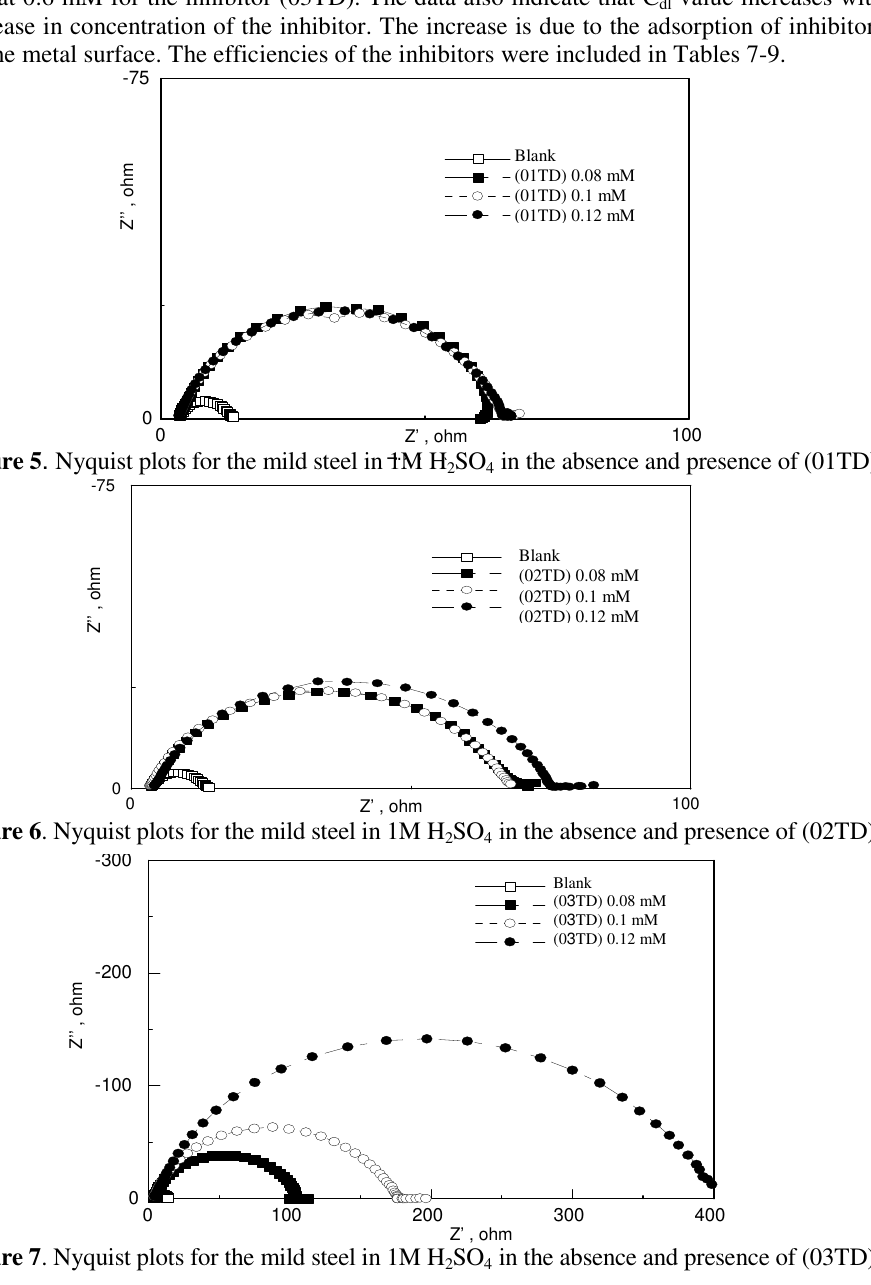
SO in the absence and presence of 2 4